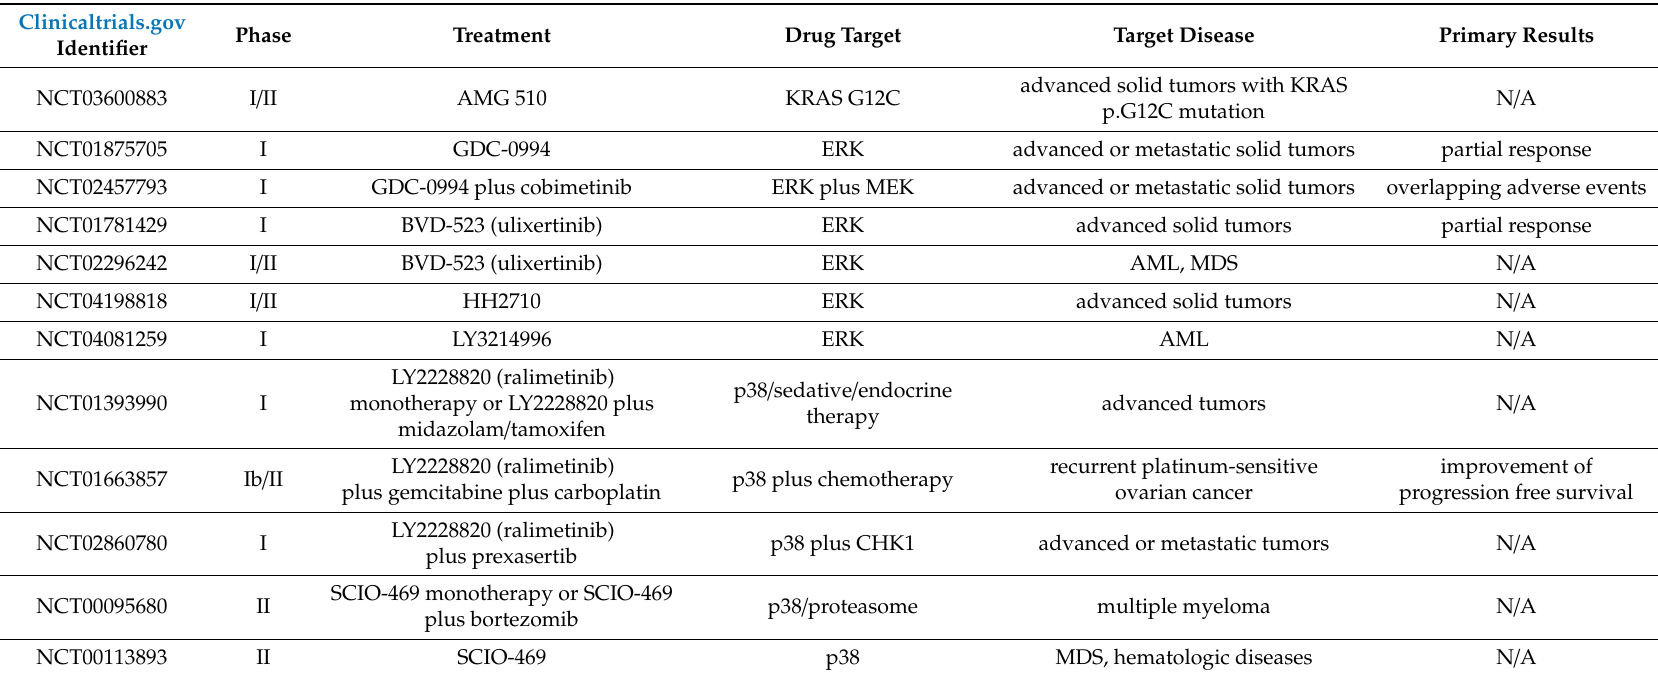
Table 3. Overview of clinical trials with novel MAPK